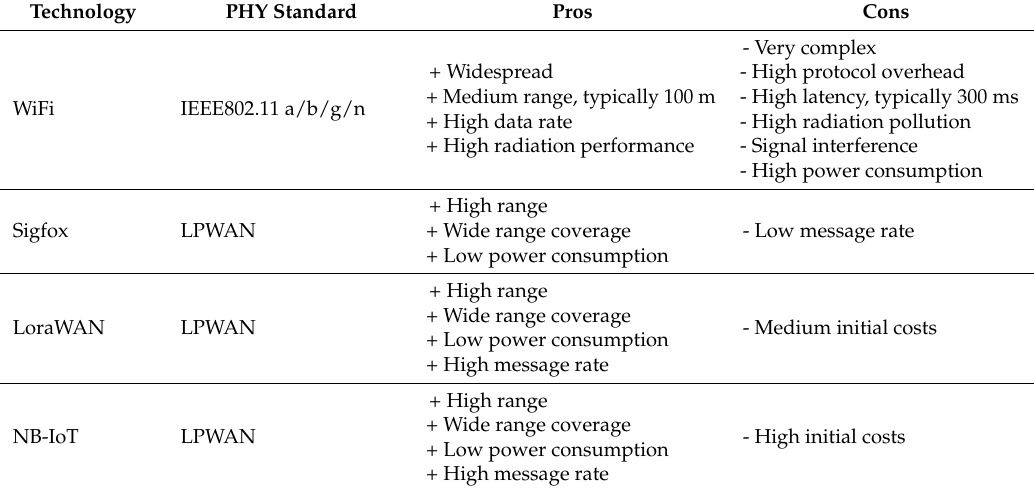
Table 2. Use case I : A comparison of the communication